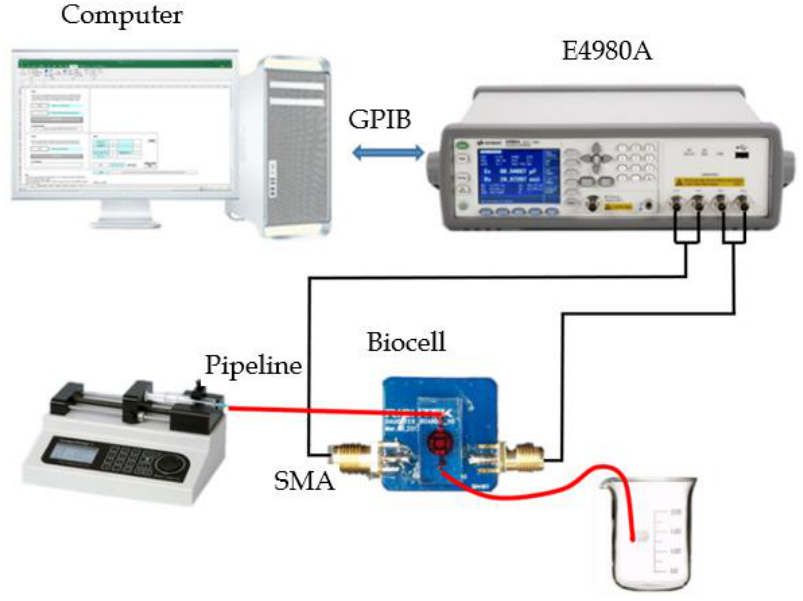
Figure 5. Cell capacitance test system.